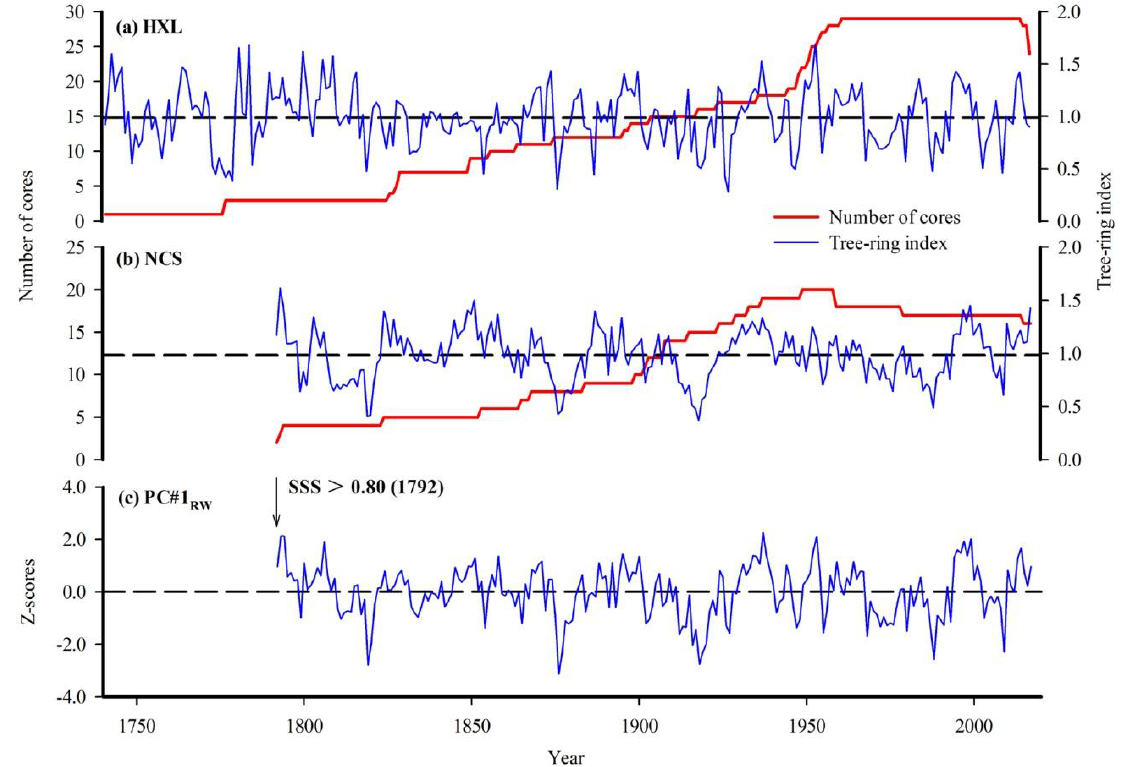
Figure 2. Plot of new ring width standard chronologies from the Hexi Forest Farm site (( a ); HXL), the Ningcui Mountain Park site (( b ); NCS), and the PC#1 of tree-ring width (( c ); PC#1 RW ). Arrow denotes the starting year with SSS > 0.80.